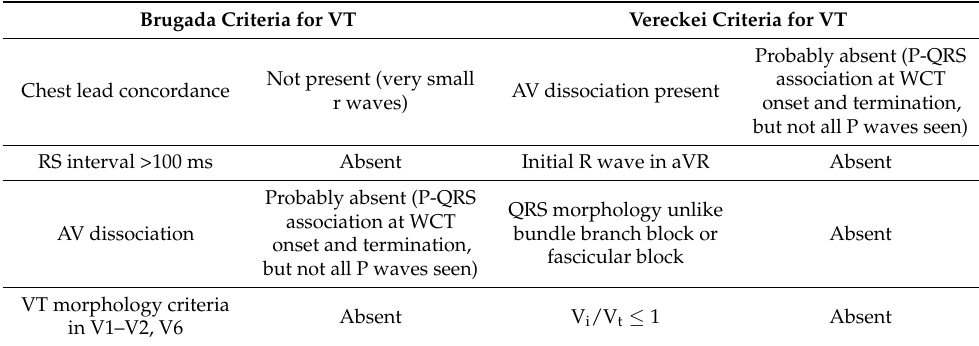
Table 1. Applying the Brugada and Vereckei criteria for the episode of wide complex tachycardia detected during Holter